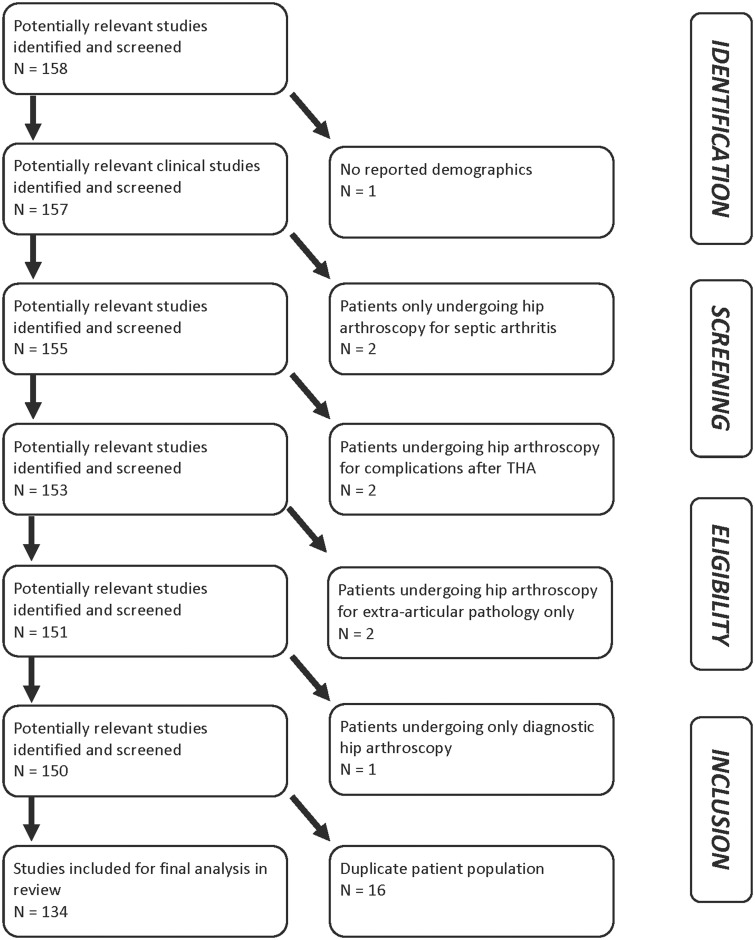
PRISMA flowchart.